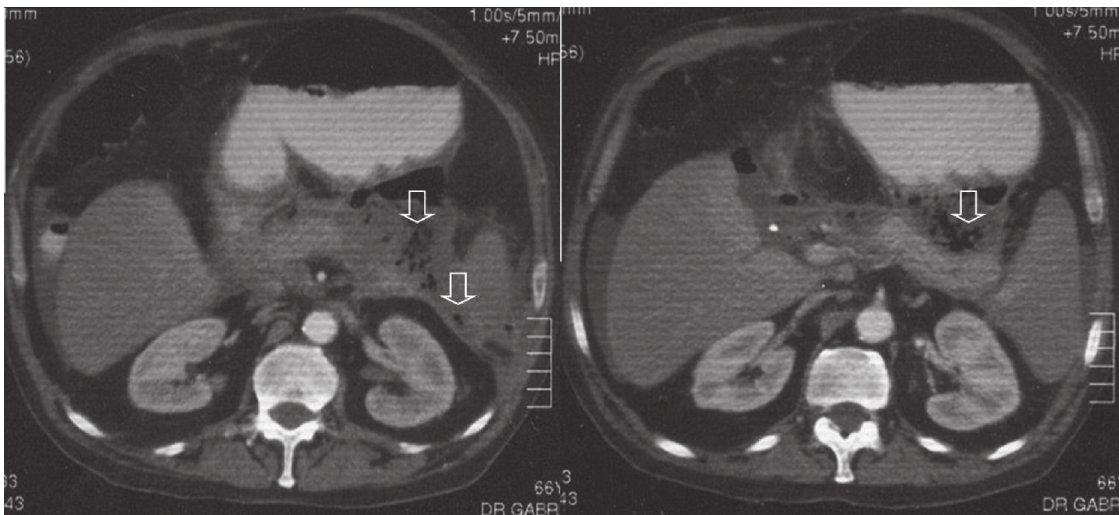
Figure 1 - Abdominal CT scan using intravenous and oral contrast media demonstrating small necrotic areas in the head and body of the pancreas, infiltration of peripancreatic fat, and presence of gas in the retrogastric and pararenal spaces